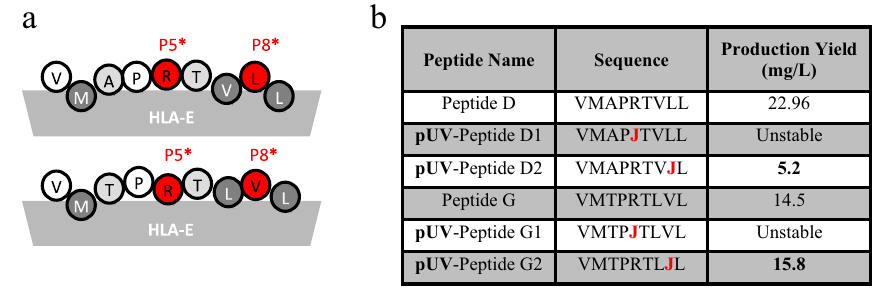
Figure 1. HLA-E anchor residues, UL40 peptides mutation, sequence of photosensitive peptides and production yields obtain using the batch protocol. ( a ) Schematic representation of UL40 peptides binding in the heavy chain HLA-E groove. Circles represent the peptide amino acids of the peptides. The dark ones are the majors anchor residues, the light gray ones are the minor anchor residues and the white ones correspond